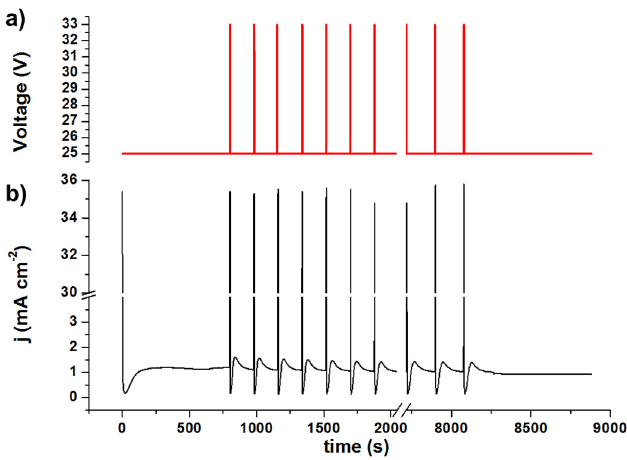
Figure 1. ( a ) Applied pulsed voltage profile and ( b ) the corresponding measured current density in the S180 type sample.